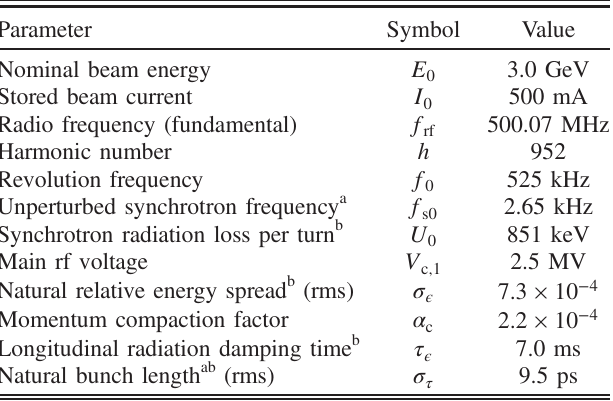
TABLE II. Principal parameters of the KEK-LS, which were assumed in this study.